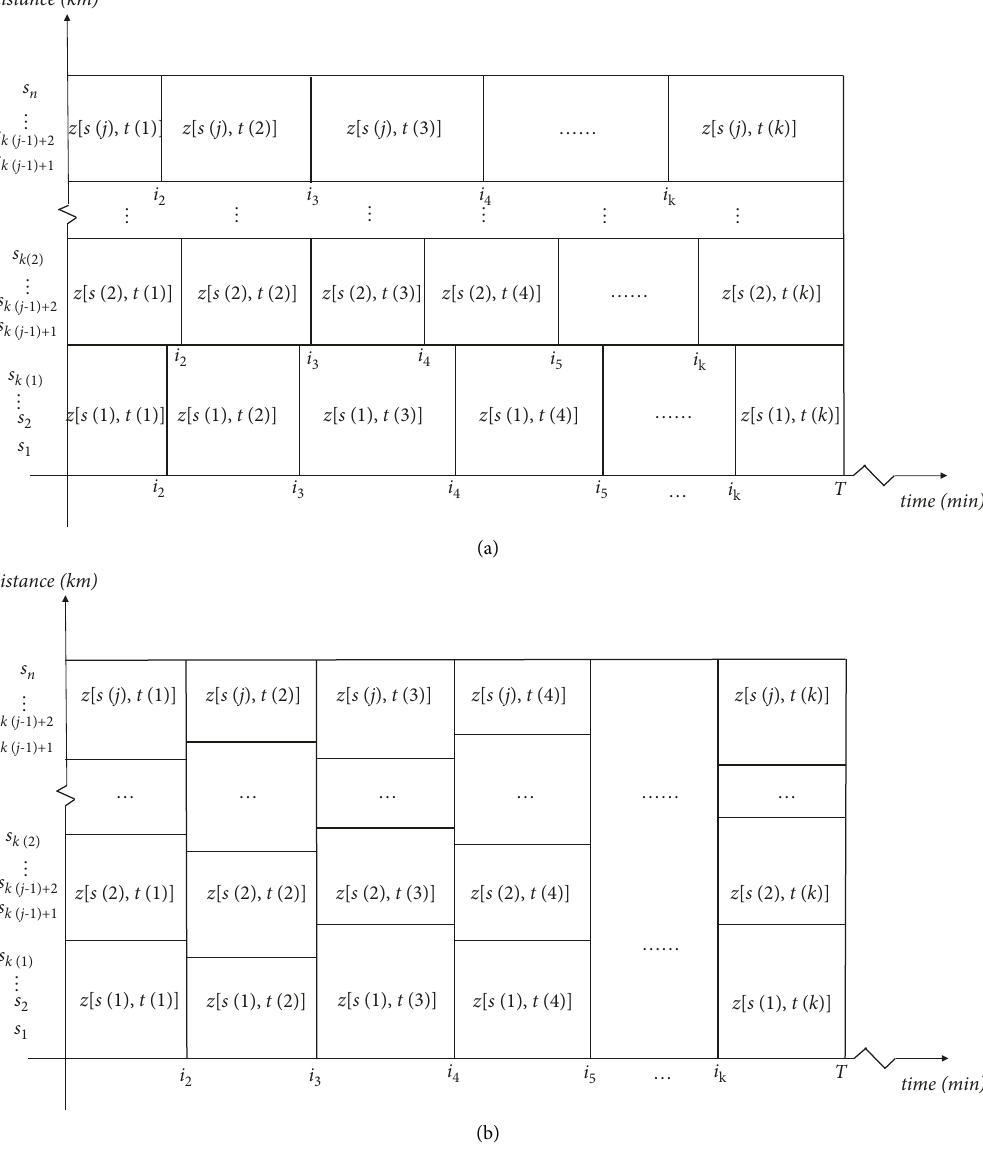
Figure 2: Schematic diagram of the division of time-space subareas and their coordination. (a) Perspective of time. (b) Perspective of